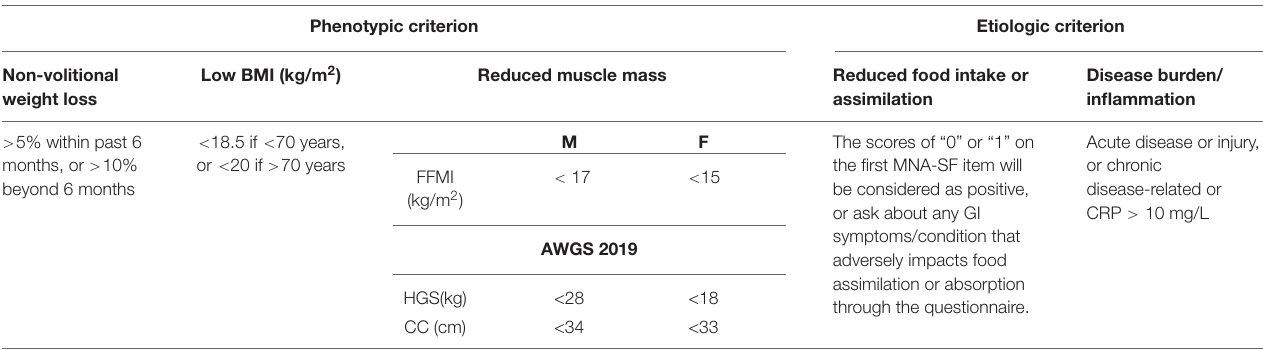
TABLE 3 | Diagnostic criteria for malnutrition based on the GLIM